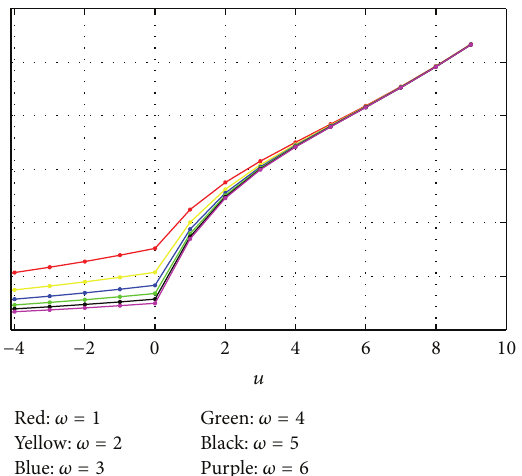
Figure 1: The expected sum of discounted dividend 𝑉(𝑢,𝑏) when 𝑏 = 10 .